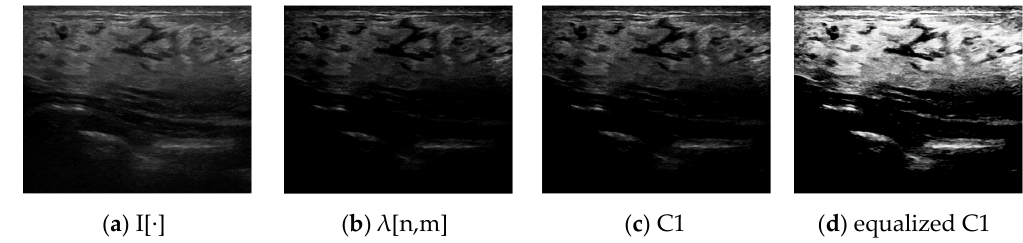
Figure 5. Image after the brightness range processing.